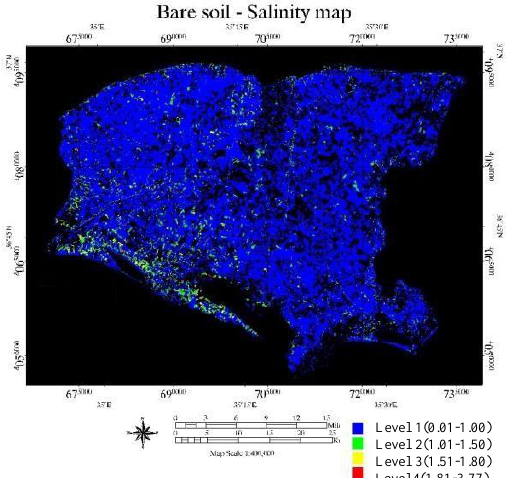
Figure 9. The map of the salt-affected bare soil fields. Density Salt- affected slice ranges wheat fields